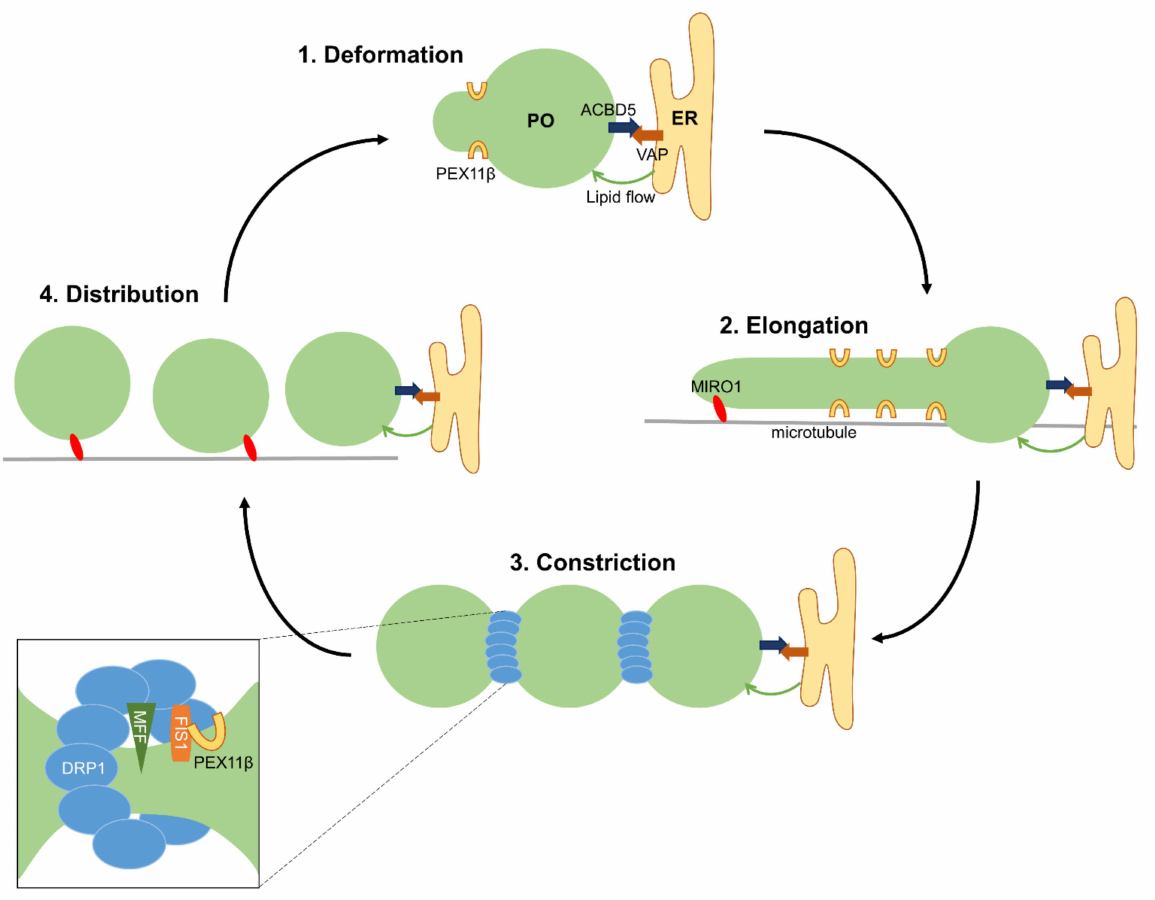
Figure 1. Growth and division of mammalian peroxisomes. Schematic of peroxisome